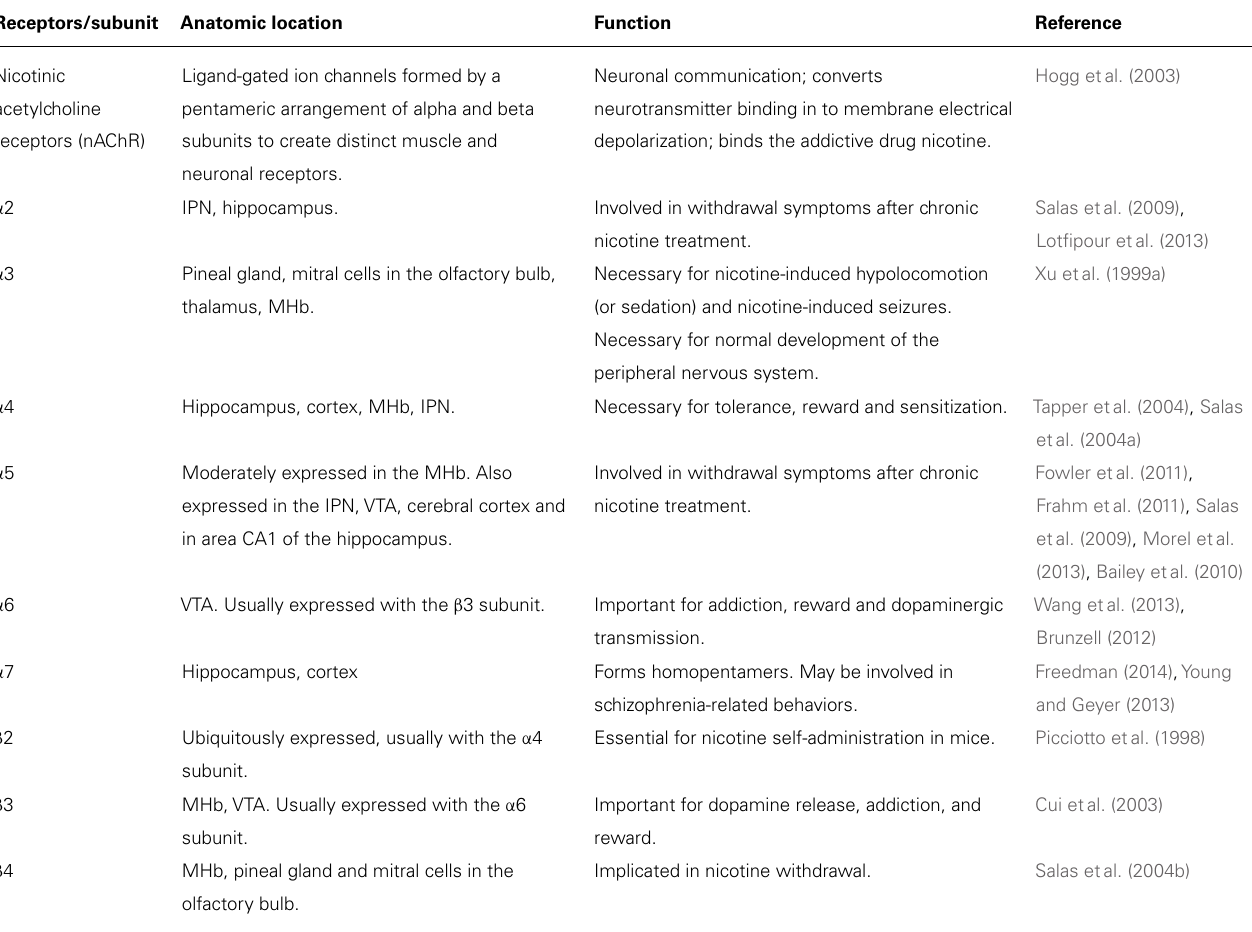
Table 2 |The function and anatomic location of nicotinic acetylcholine receptors (nAChR) associated with the habenula. Receptors/subunit Anatomic location Function